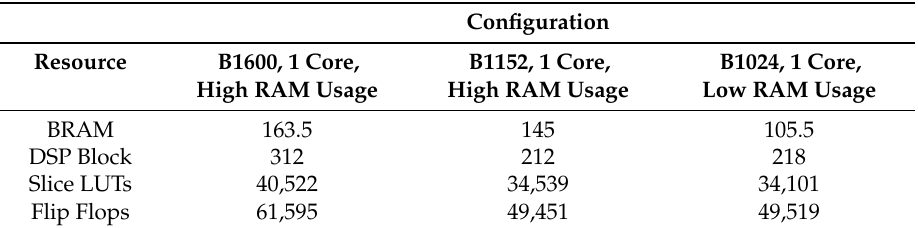
Table 8. Deep Learning Processing Unit (DPU) Resource Utilization.